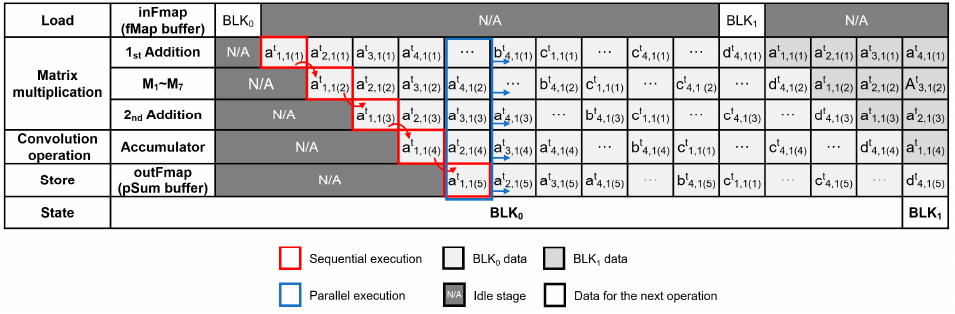
Figure 10. Execution flow of the 6-stage pipeline in CENNA (6-stages: Load, 3-stage Matrix Multiplication, Convolution Operation and Store).